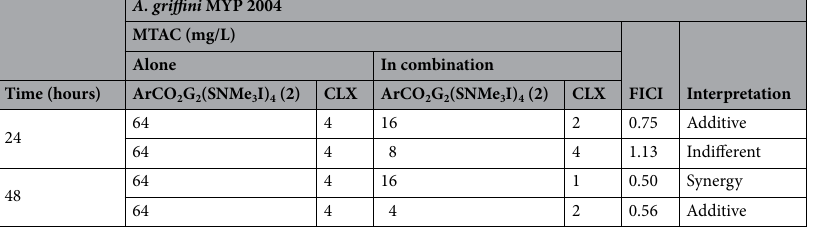
Table 4. FICI in A. griffini MYP2004 trophozoites and interpretation of the effect MTAC (mg/L) for ArCO